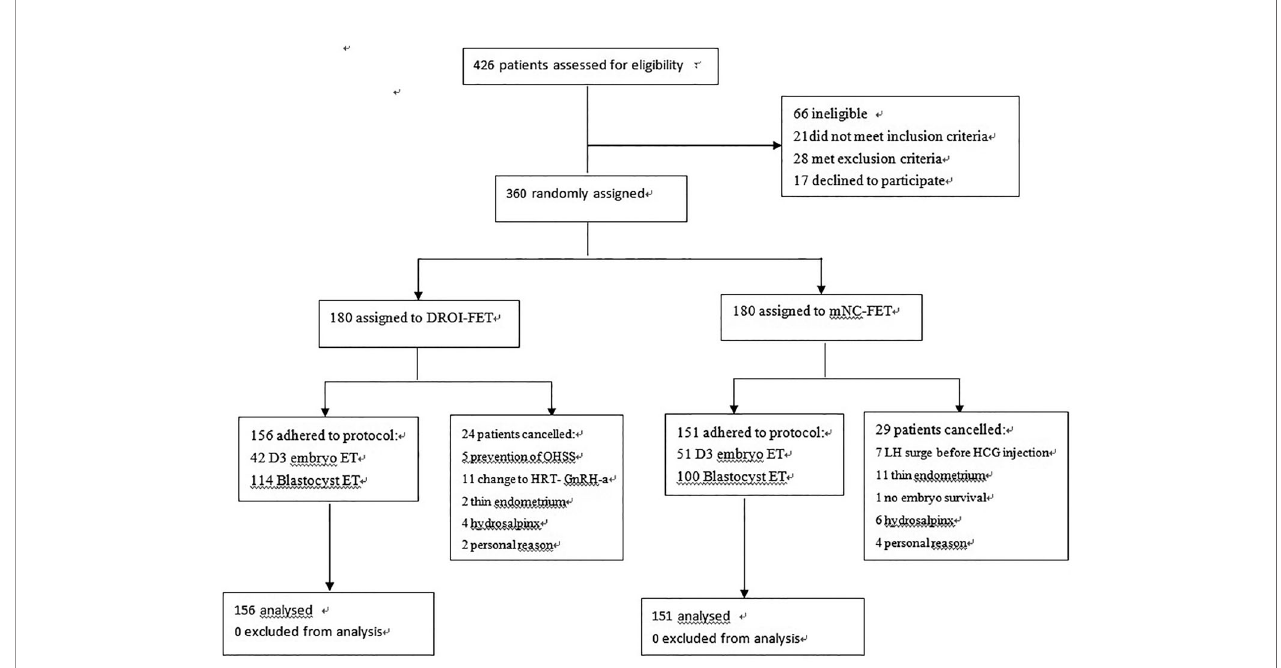
FIGURE 2 | Flowchart showing of enrollment and randomization of study patients.